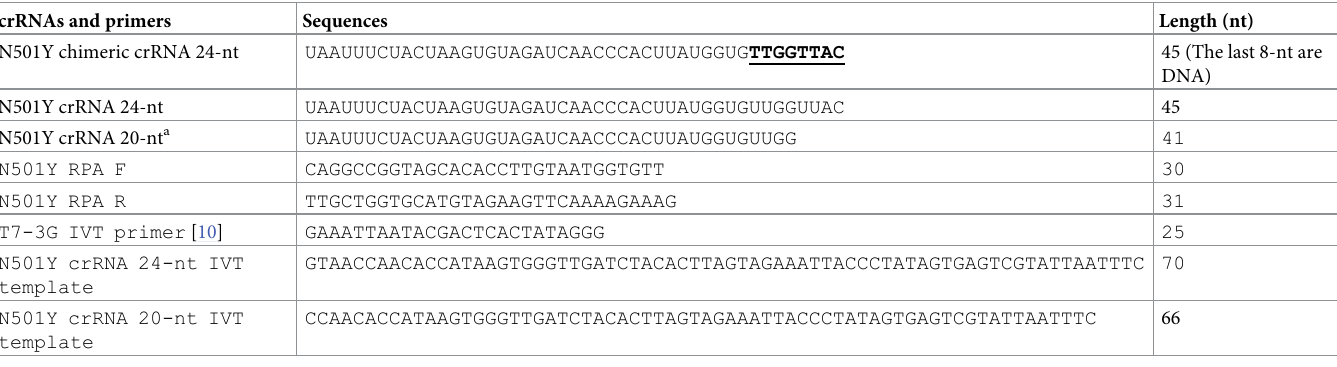
Table 1. Sequences of primers and crRNAs used in this